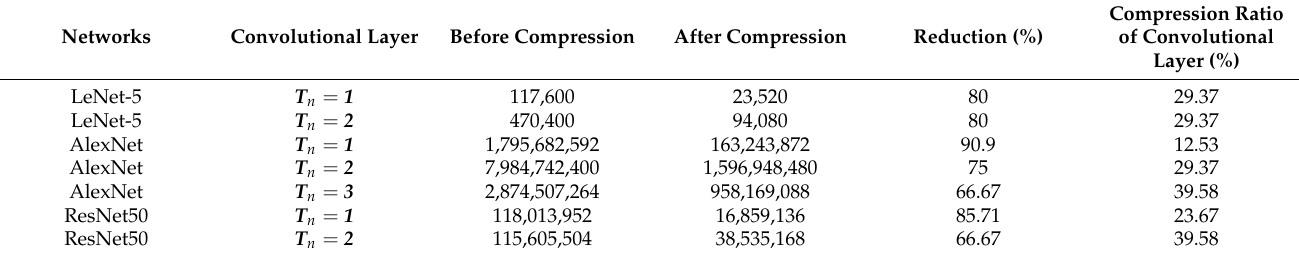
Table 2. The number of multiply–accumulate calculations per inference for each convolutional layer of LeNet-5.